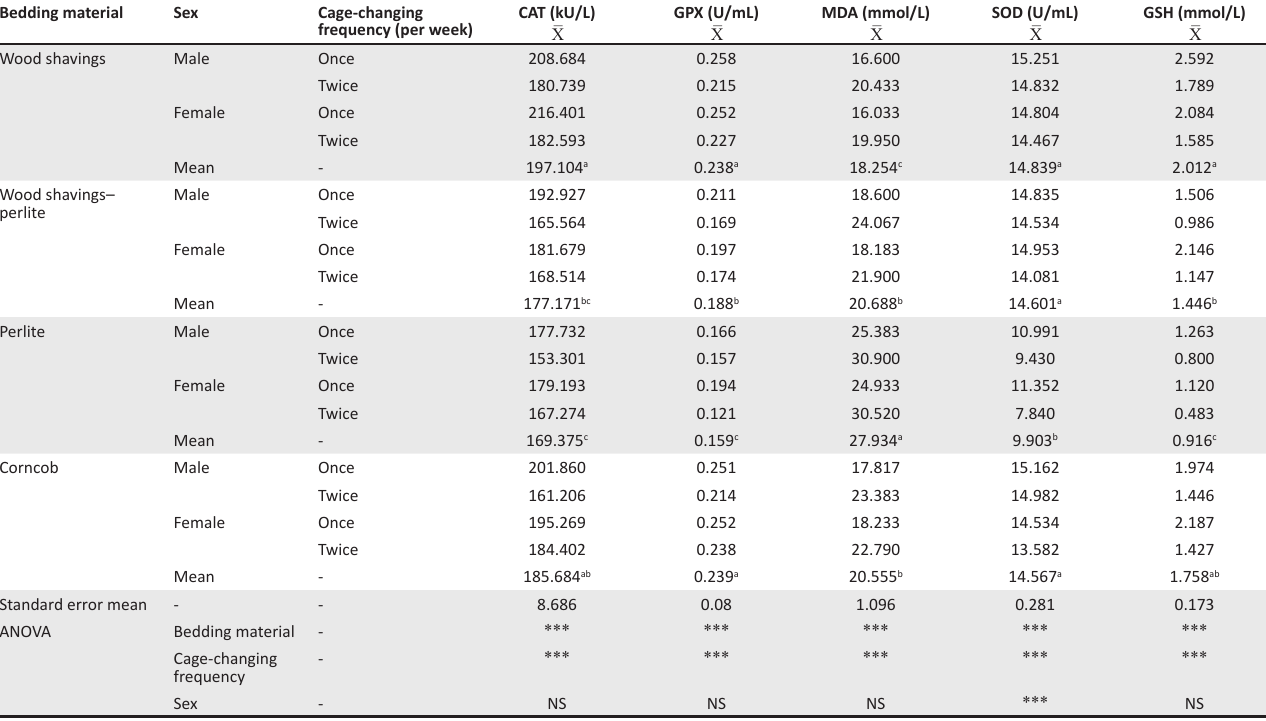
FIGURE 6: Histopathologic degeneration and inflammation degrees on the skin of male and female rats according to changing frequency and bedding material. (a) Male degeneration, (b) female degeneration, (c) male inflammation and (d) female inflammation. TABLE 1: Results of biochemical analysis performed on blood samples according to sex and cage-changing frequency in Sprague-Dawley rats. Bedding